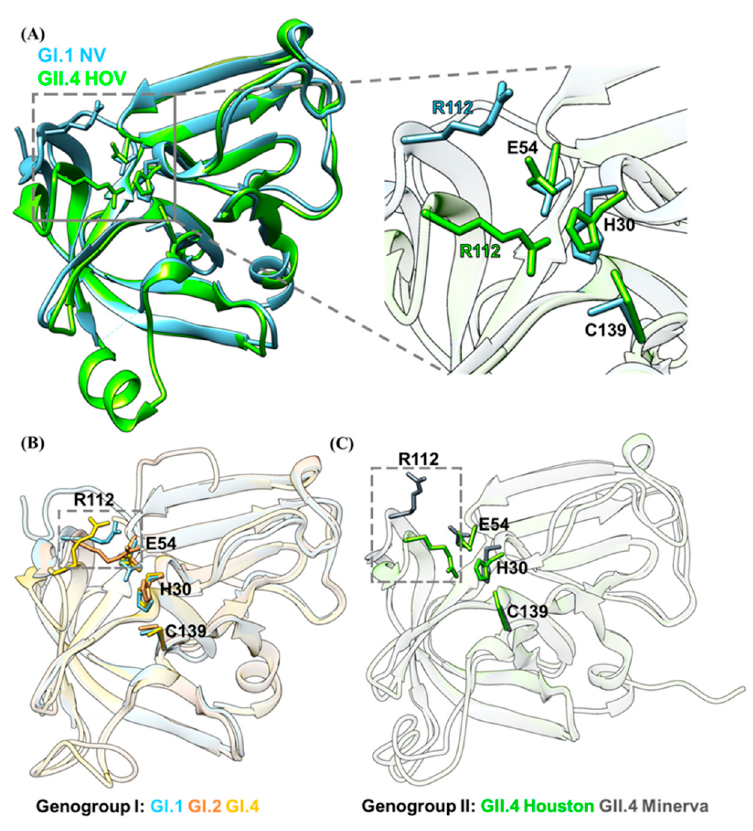
Figure 3. Interactions of the active site residues are affected by the Arg112 residue. ( A ) Comparison of the active sites of GI.1 Norwalk (cyan) and GII.4 Houston (green) depicts a different orientation of the His30 residue. In GI.1 Norwalk protease, the Arg112 residue is positioned away from the active site, therefore allowing His30 to interact with Glu54. However, in GII.4 Houston protease, such interaction between His30 and Glu54 is not observed, as the Arg112 residue is pointed toward the active site and interacts with His30. ( B ) Active site comparison within the GI genogroup protease (Norwalk, cyan; Chiba, yellow; Southampton, orange) indicates that the Arg112 residue (within the grey box) of the GI.2 Southampton protease is also pointed toward the active site. ( C ) Active site comparison within the GII genogroup protease (Houston, green; Minerva, grey) indicates that even though Houston and Minerva are in the same genogroup, the orientation of the active site residues are different due to the position of the Arg112 residue (within the grey box).